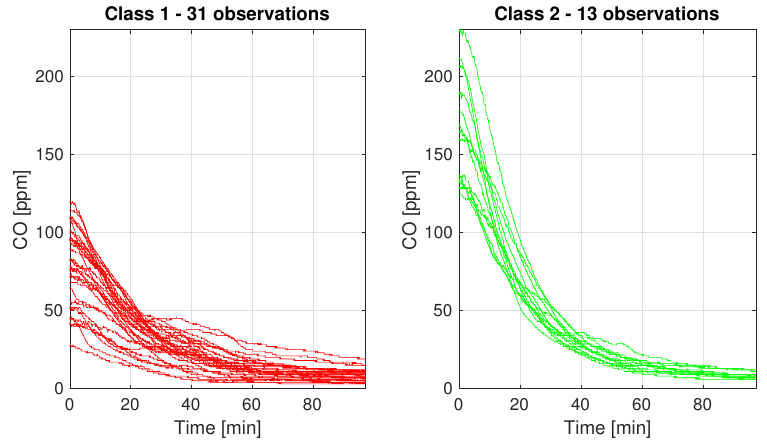
Figure 14. Peaks’ decreasing